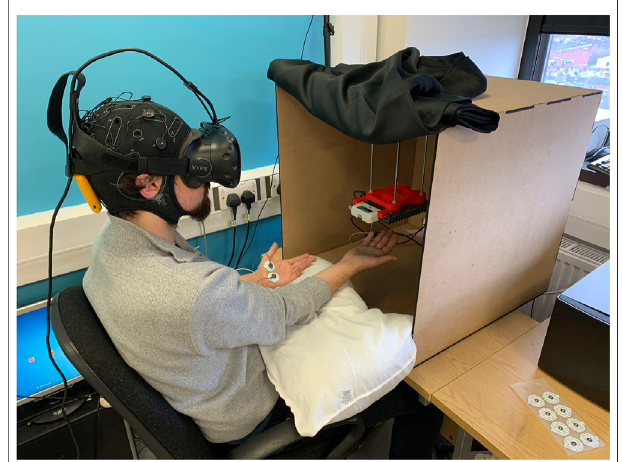
FIGURE 4 | Photo of apparatus setup with user in position.